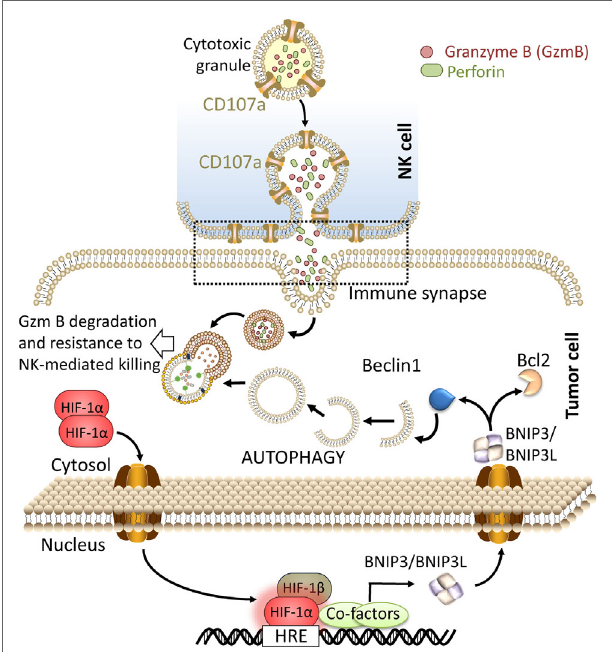
FiGURe 1 | Targeting autophagy in hypoxic tumor cells restores natural killer (NK)-mediated tumor cell killing by preventing the degradation of granzyme B. The recognition of tumor cells by NK leads to the release of cytolytic granules containing perforin and granzyme B from NK cells. These cytotoxic granules enter to the tumor cells through endocytosis and traffic to enlarged endosomes called “gigantosomes.” Following the formation of pores in the “gigantosome” membrane, granzyme B is released in the cytoplasm and initiates cell death. Under hypoxia, excessive autophagy leads to the fusion of “gigantosomes” with autophagosomes and the subsequent degradation of granzyme B. Degraded granzyme B is no longer able to induce tumor cell death, therefore, targeting autophagy prevents the degradation of granzyme B and restores NK-mediated